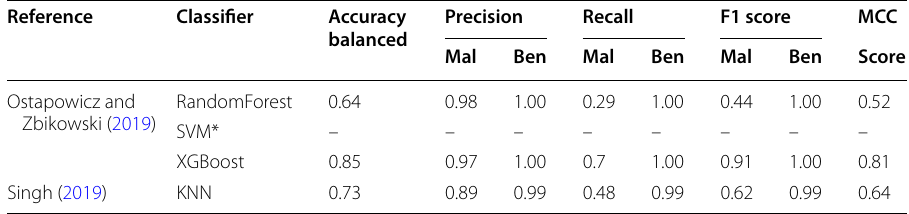
Here, we use 59 features and both EOA and SC dataset configuration. Here, we also report the Matthews Correlation Coefficient (MCC) score *Did not converge as the dataset was